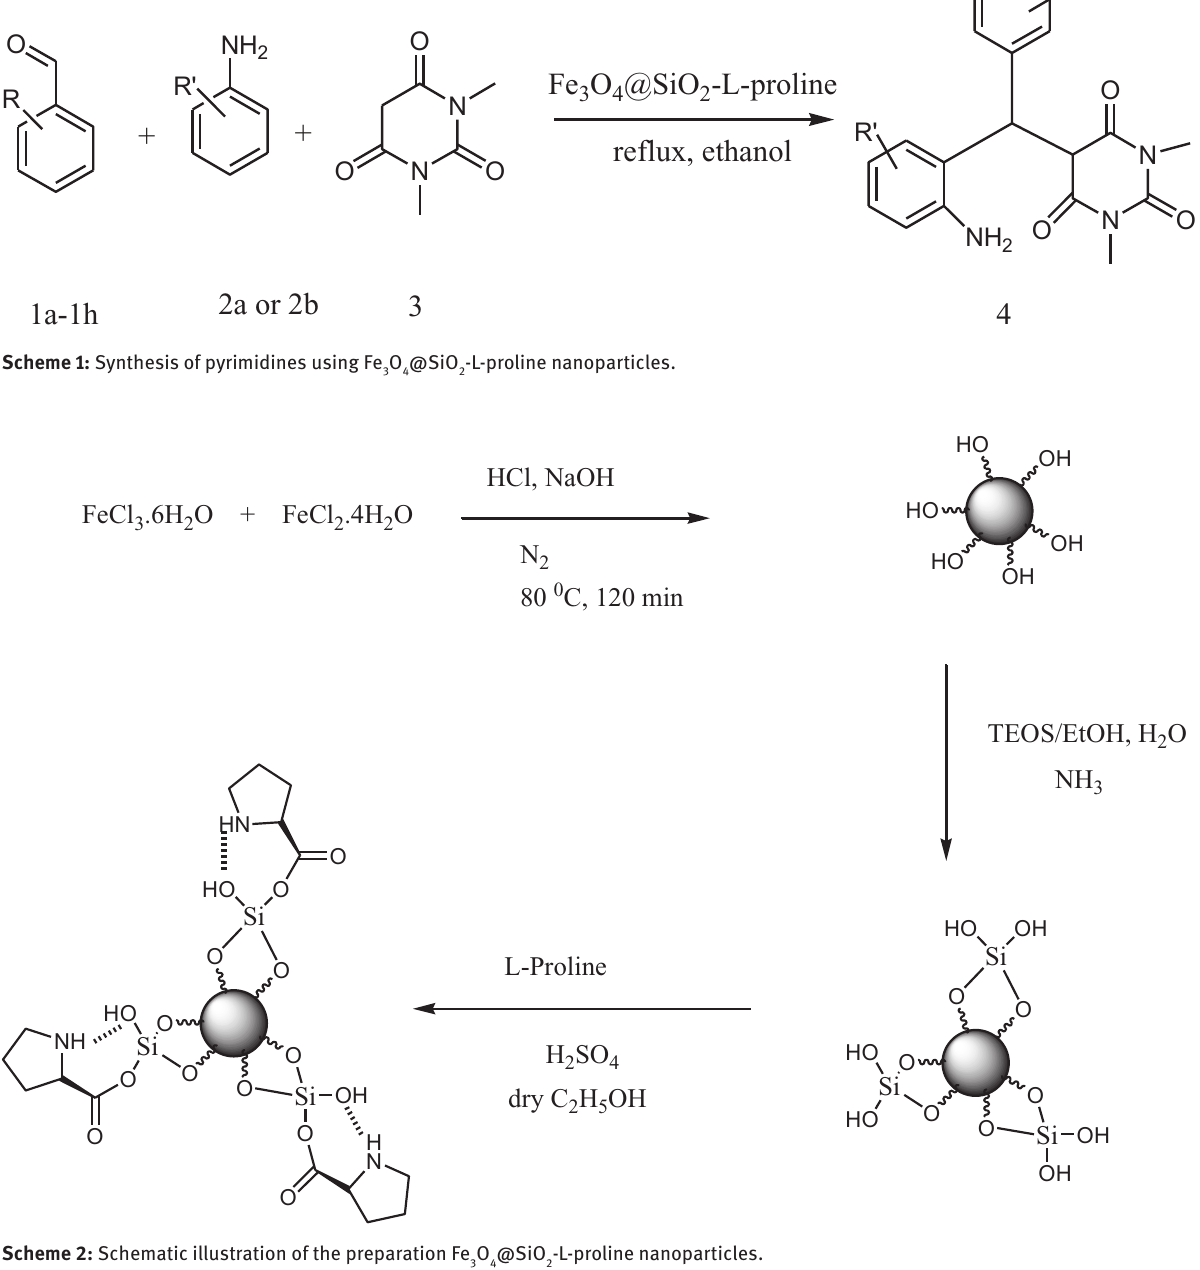
Scheme 1: Synthesis of pyrimidines using Fe